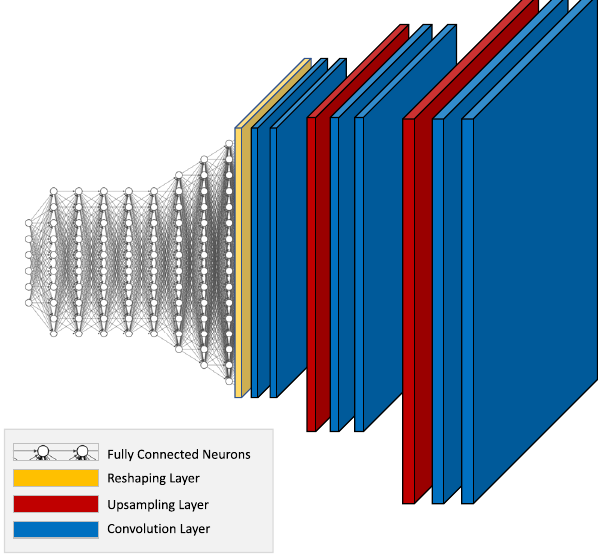
FIG. 10. Comparison of Bayesian neural network predictions on (a) in-sample test dataset samples and (b) OOD dataset samples.